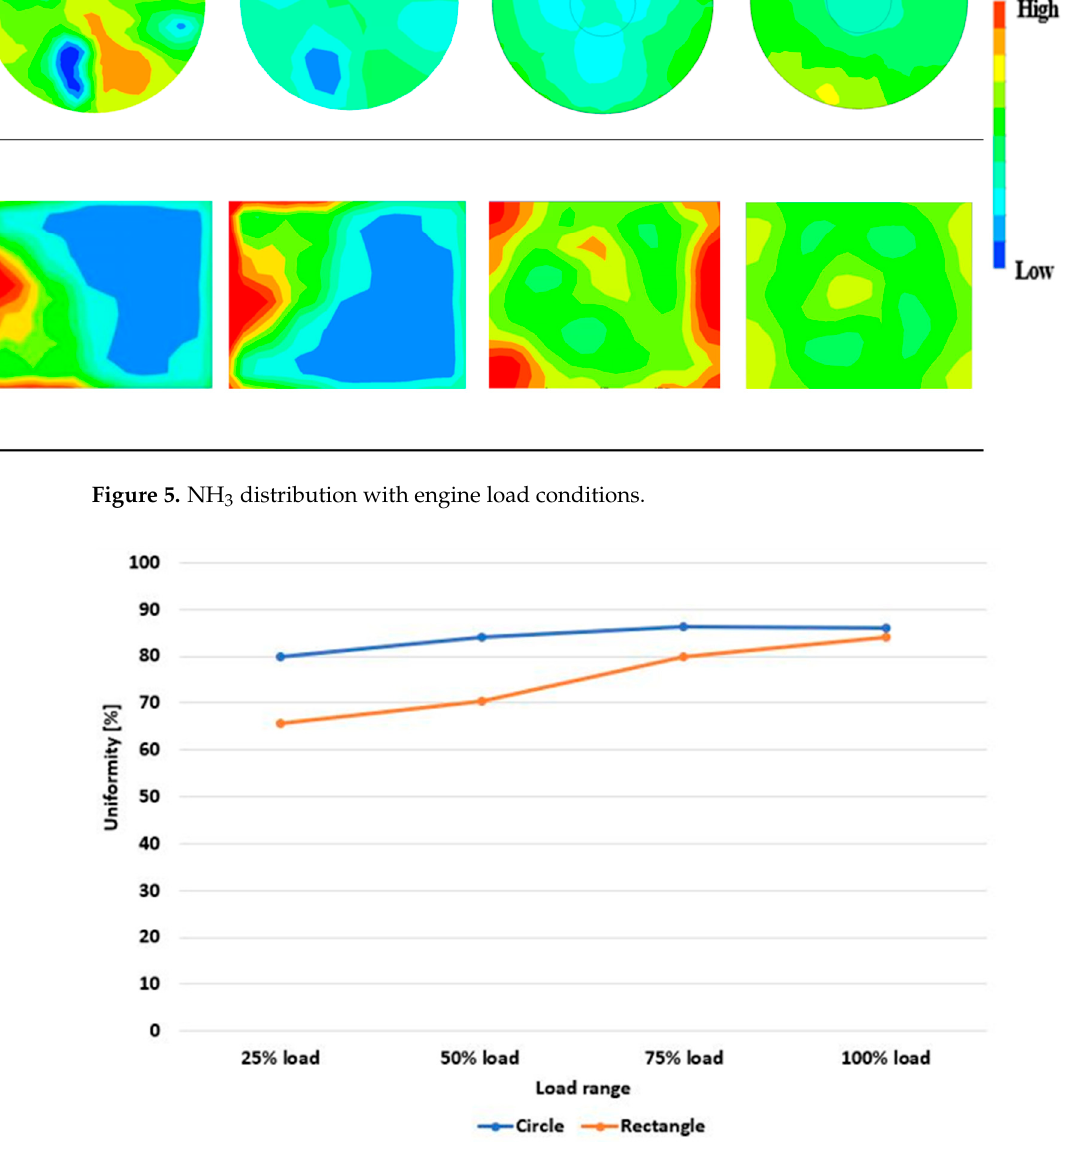
Figure 6. Correlation between uniformity and engine load.